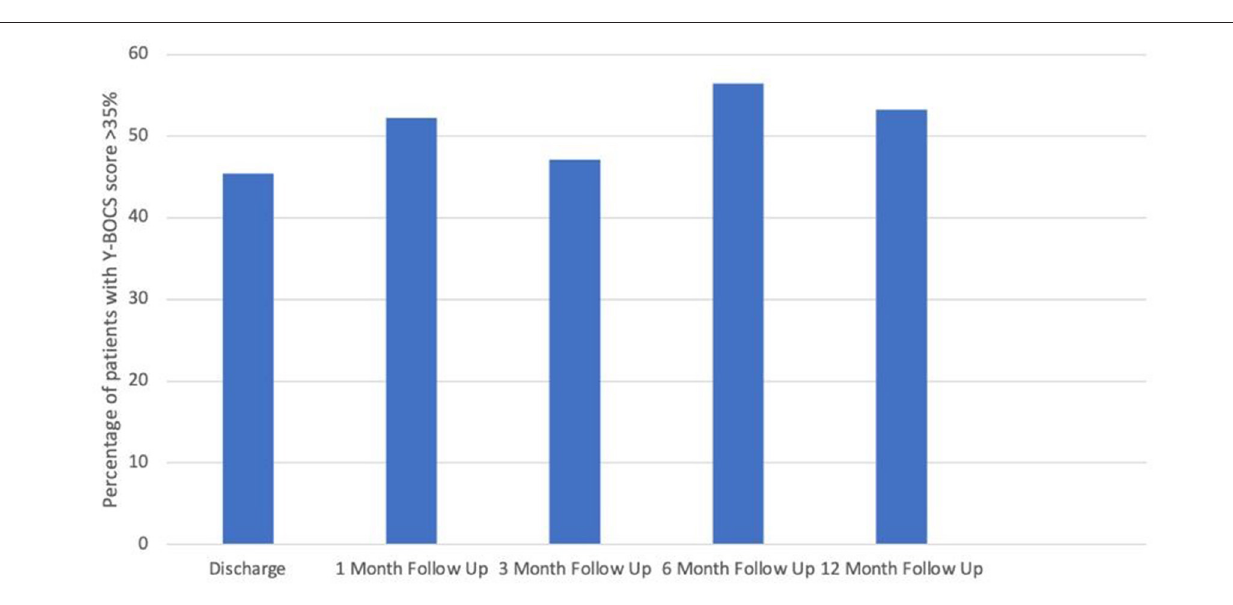
FIGURE 2 | Percentage of patients with > 35% improvement in Y-BOCS score at each follow up point (compared with admission Y-BOCS